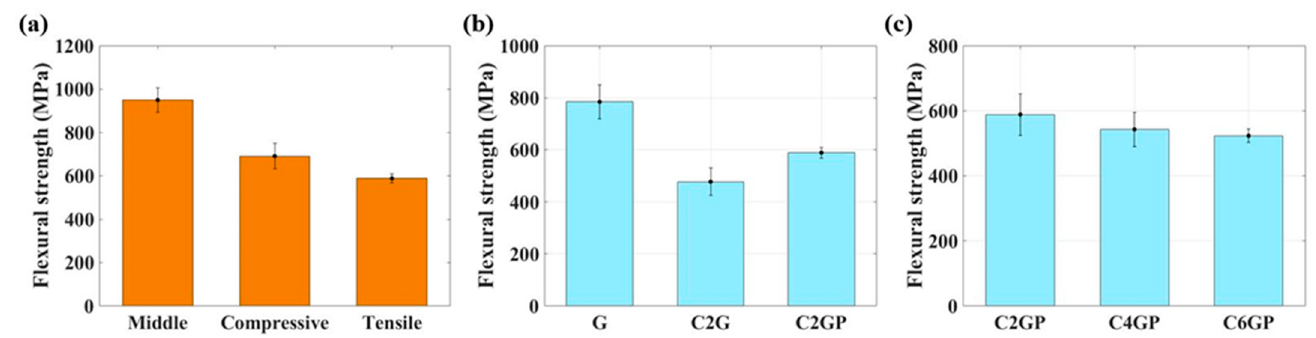
Figure 7. Flexural strength of ( a ) each specimen’s middle layer, compressive side, and tensile side; ( b ) G, C2G, and C2GP; and ( c ) C2GP, C4GP, and C6GP.